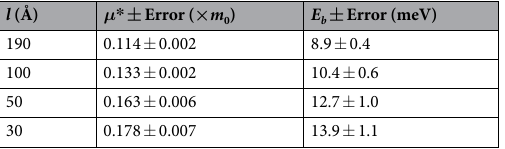
Table 1. Summary of reduced effective mass and binding energy of exciton with variation in QW thickness ( m 0 is the free electron mass).